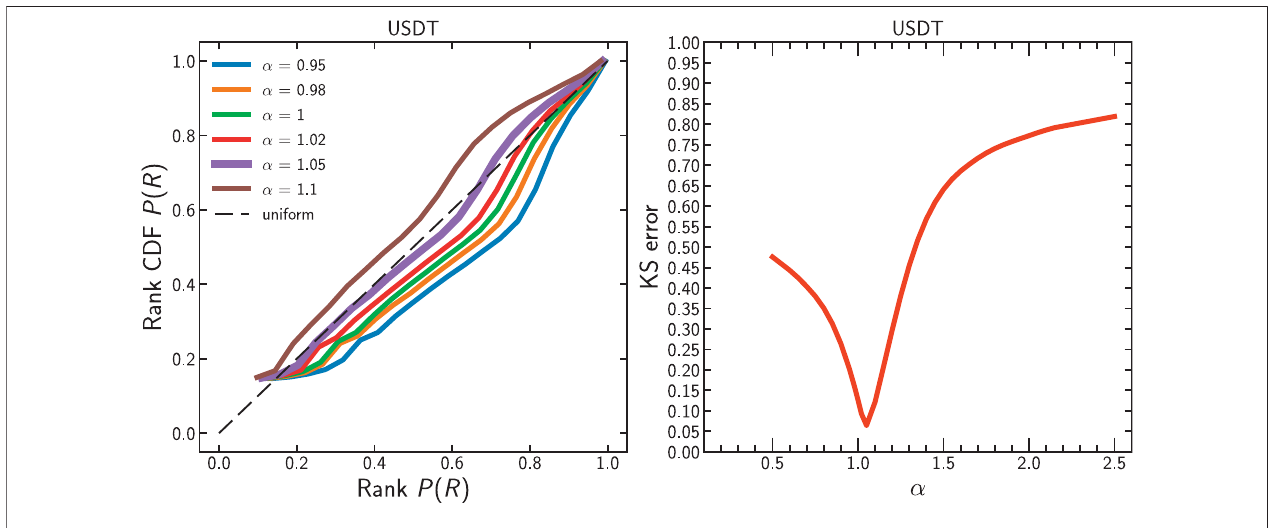
FIGURE 9 | LNK. Rank function for different α . KS distance. α value minimising